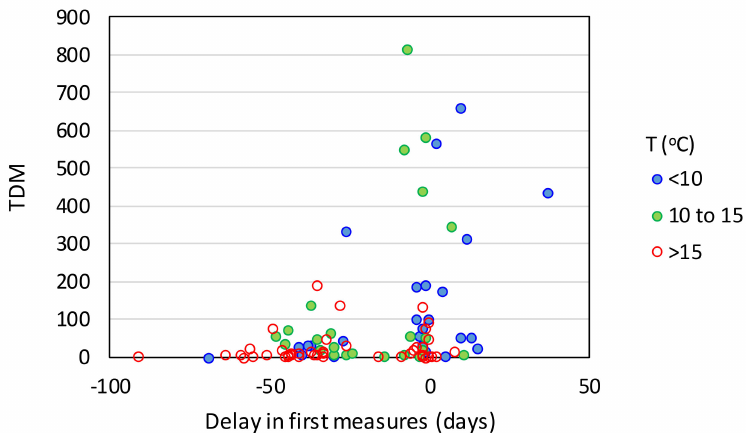
Figure 15. Total deaths per million as function of the time di ff erence between the o ffi cially recorded first case and the first government measures for di ff erent temperature groups (HDI >